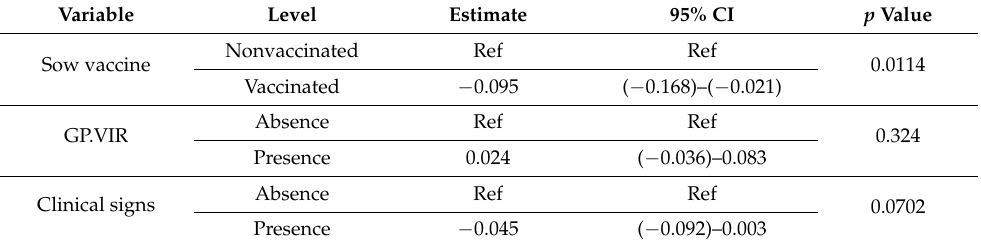
Table 3. Final model with the association of body temperature of piglets and other predictor variables using multivariable linear regression with repeat measurements while accounting for sow identity as random effect.